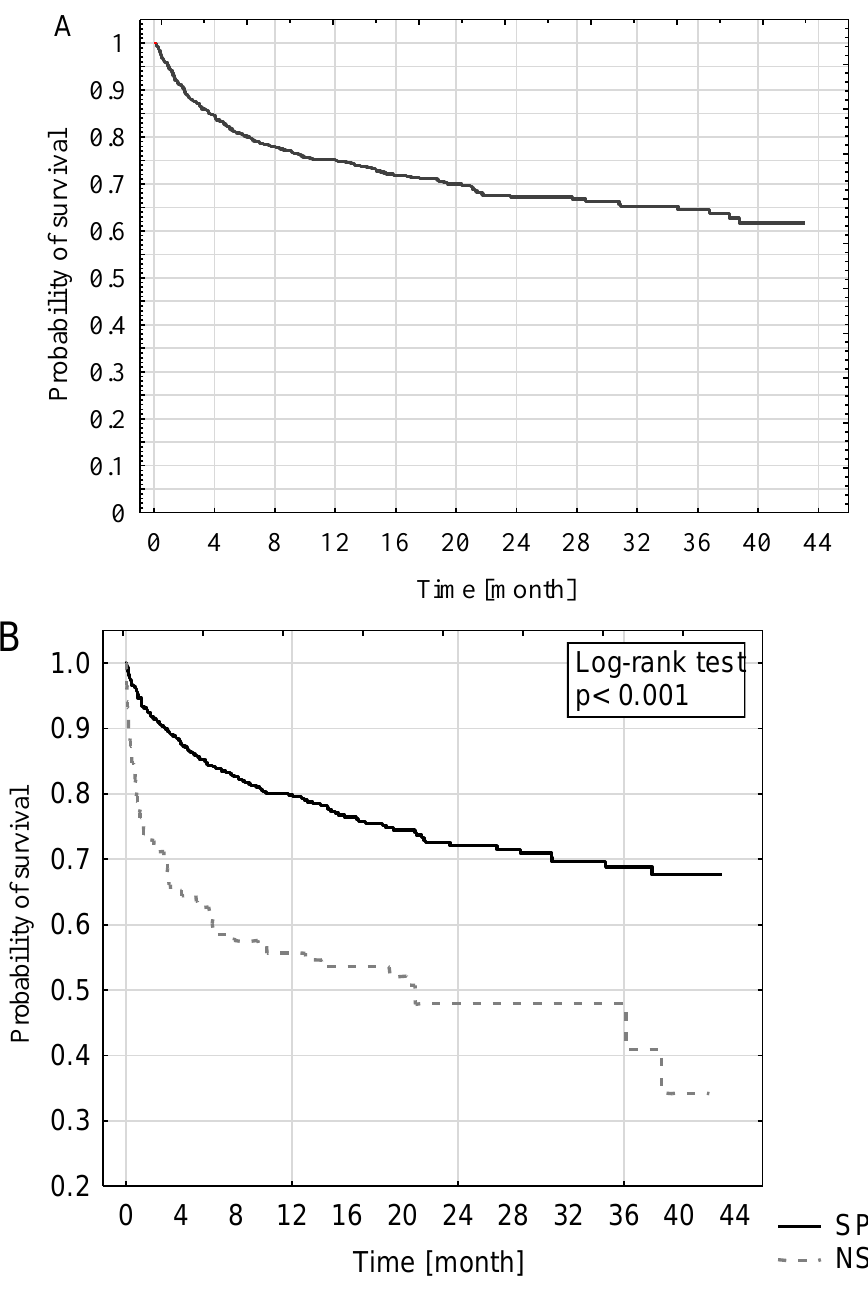
Figure 3. Kaplan-Mayer curves of all ICU survivors ( A ), including surgical and nonsurgical patients ( B ). The investigated scores were statistically significantly higher in ICU survivors who died during the follow-up compared with those who were still alive (Table 4), also in the subgroup analysis of SP and NSP patients. Table 4. SAPS II, APACHE II, SOFA scores and post-ICU mortality in ICU survivors. Score